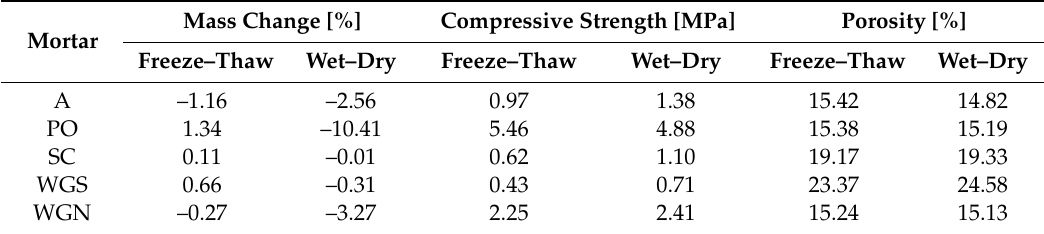
Table 5. Mass change and compressive strength of the mortars after durability tests.